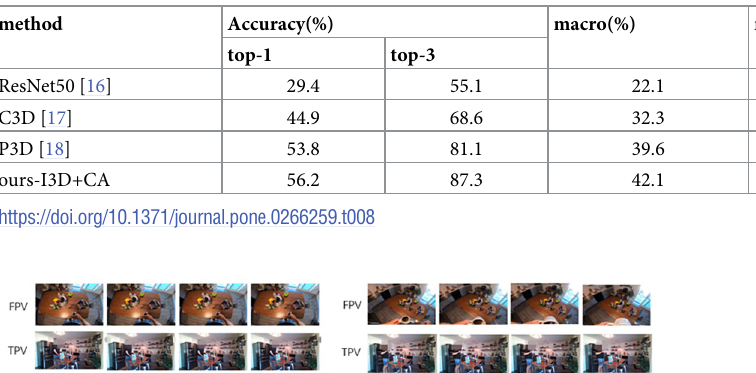
Table 8. Compositional action recognition on IKEA ASM dataset.